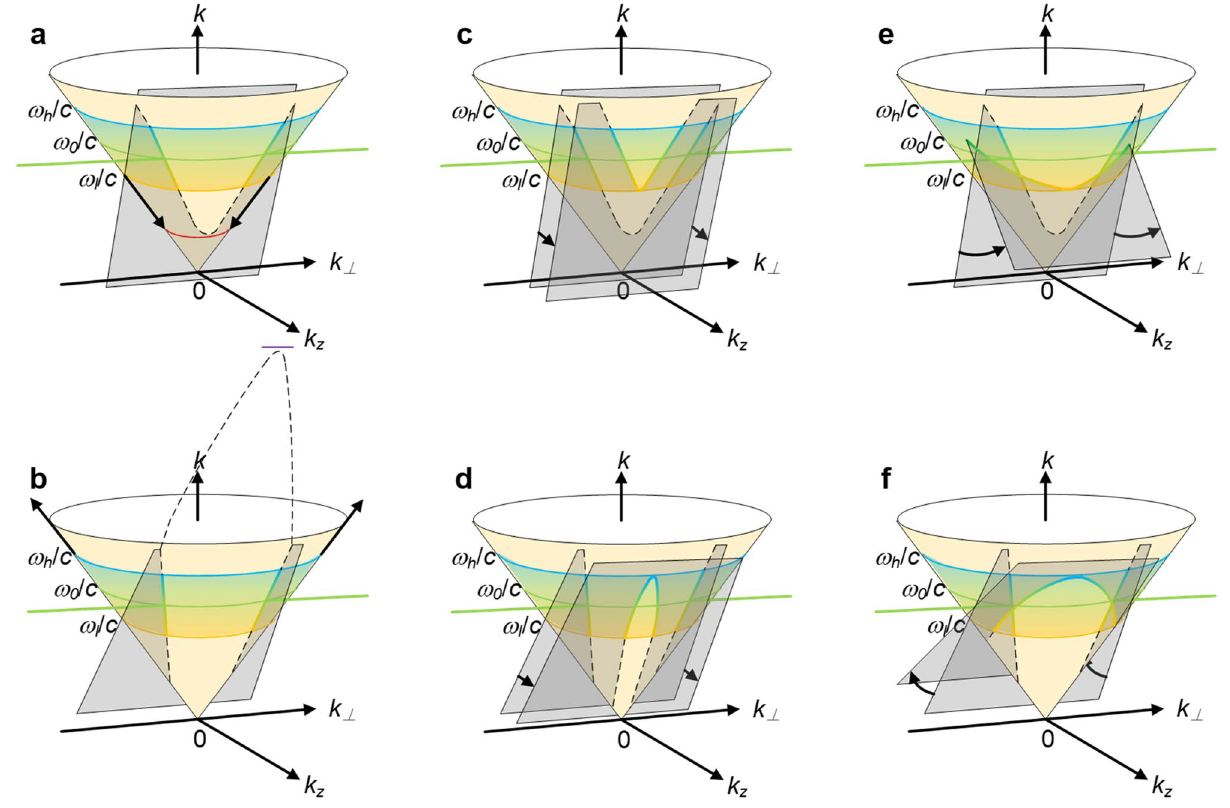
Figure 5. Group-velocity-tunable propagation-invariant optical wave-packet generated by the conical superposition is subset of space–time wave-packet. Spatiotemporal spectrum (colored thick line on light-cone) of propagation-invariant optical wave-packet generated by the conical superposition is a part of that of space– time wave-packet, excluding k ⊥ = 0. When ( a,b ) spectral range of pulse is enhanced, or spectral plane is ( c,d ) shifted towards positive direction of k z -axis, or spectral plane is dramatically rotated ( e ) counterclockwise or ( f ) clockwise, spatiotemporal spectrum of propagation-invariant optical wave-packet is changed from two separate curves about k ⊥ = 0 plane into a single continuous one, and propagation-invariant optical wave-packet becomes space–time wave-packet. ω l , ω 0 , and ω h are the lowest, center and highest angular frequencies of pulse. Figure generated by Microsoft® Visio® 2013 50